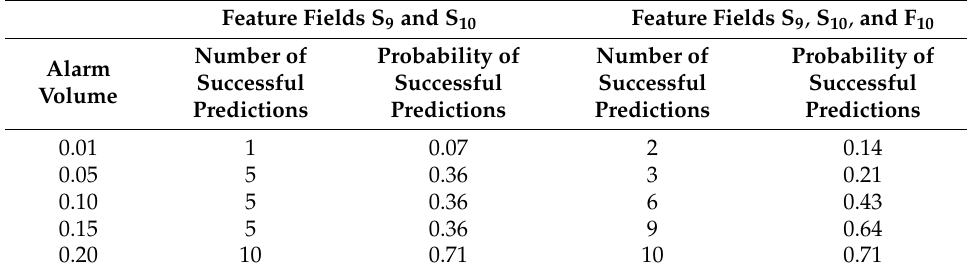
Table 6. Japan. Probabilities of earthquake prediction with magnitudes m ≥ 6.0 from seismological fields and from the same fields together with the GPS field.